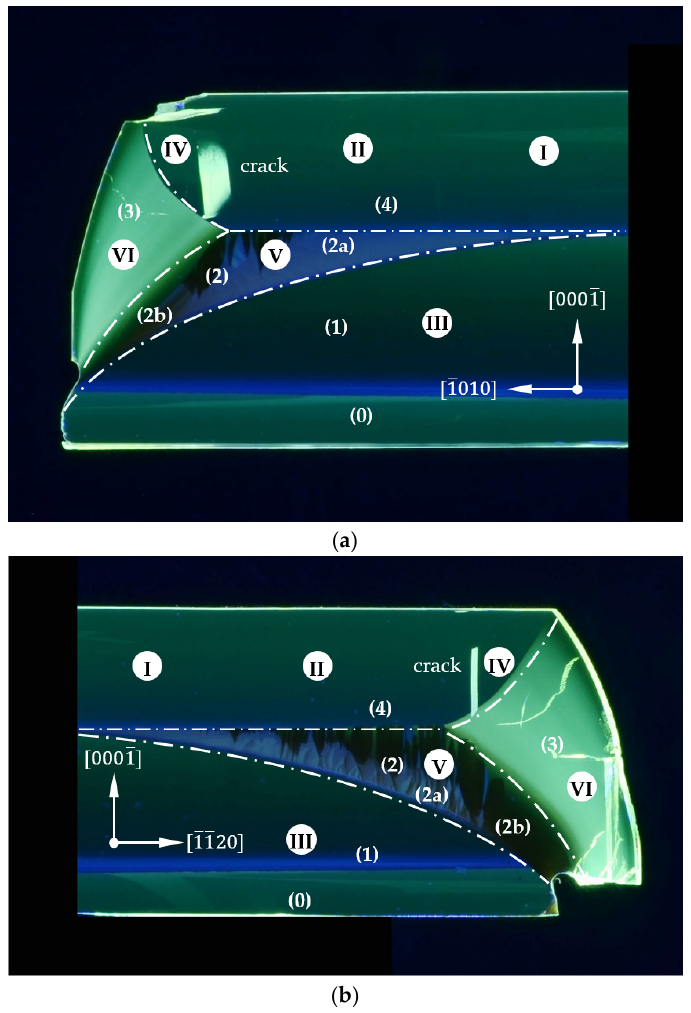
Figure 3. Slices of an Am-GaN crystal grown on the lenticular seed. OM images gathered under UV illumination: ( a ) (12(cid:3364)10) plane and ( b ) (1(cid:3364)100) plane. Five areas separated by clear interfaces were named with Arabic numerals in brackets: (0)—pre-seed; (1)—lens seed; (2)—area of the (0001(cid:3364)) plane recovery; two sub-areas: (2a) and (2b), differing in the intensity of UV luminescence, were distinguished; (3)—area of lateral growth; (4) area of GaN grown in the [0001(cid:3364)] direction. One crack was clearly visible. Roman numerals (I–VI) were used to represent the six locations of HRXRD and SIMS measurements called “analysis points (APs)”.